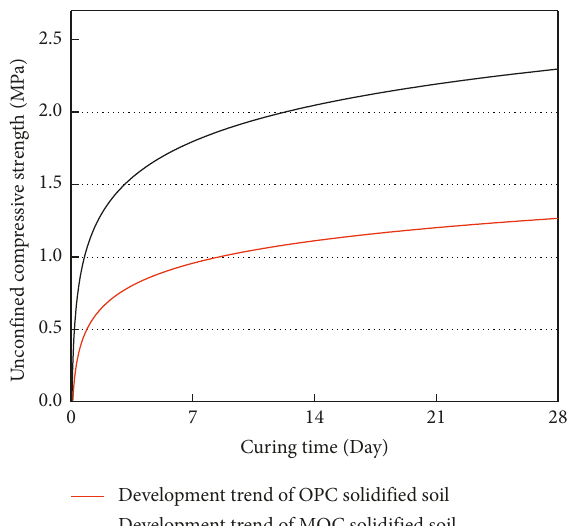
Development trend of OPC solidified soil Development trend of MOC solidified soil Figure 9: Strength prediction curve of OPC and MOC solidified soil.